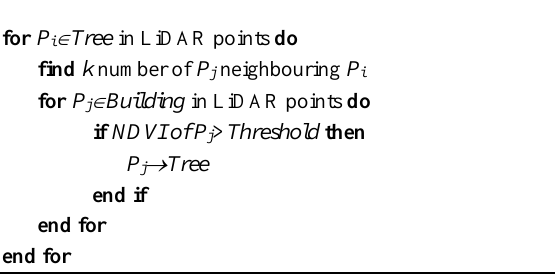
Algorithm 1. The use of NDVI in LiDAR